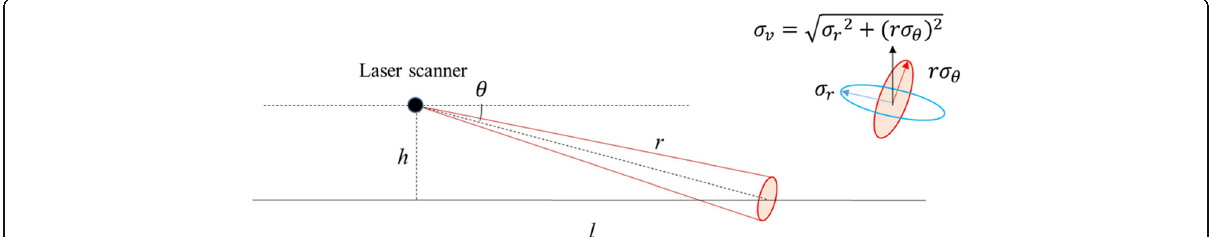
Fig. 2 Laser scanner error model. θ : vertical angle, r : range, σ r : standard deviation of radial ranging error, σ θ : standard deviation of vertical angular error, σ v : standard deviation of total vertical